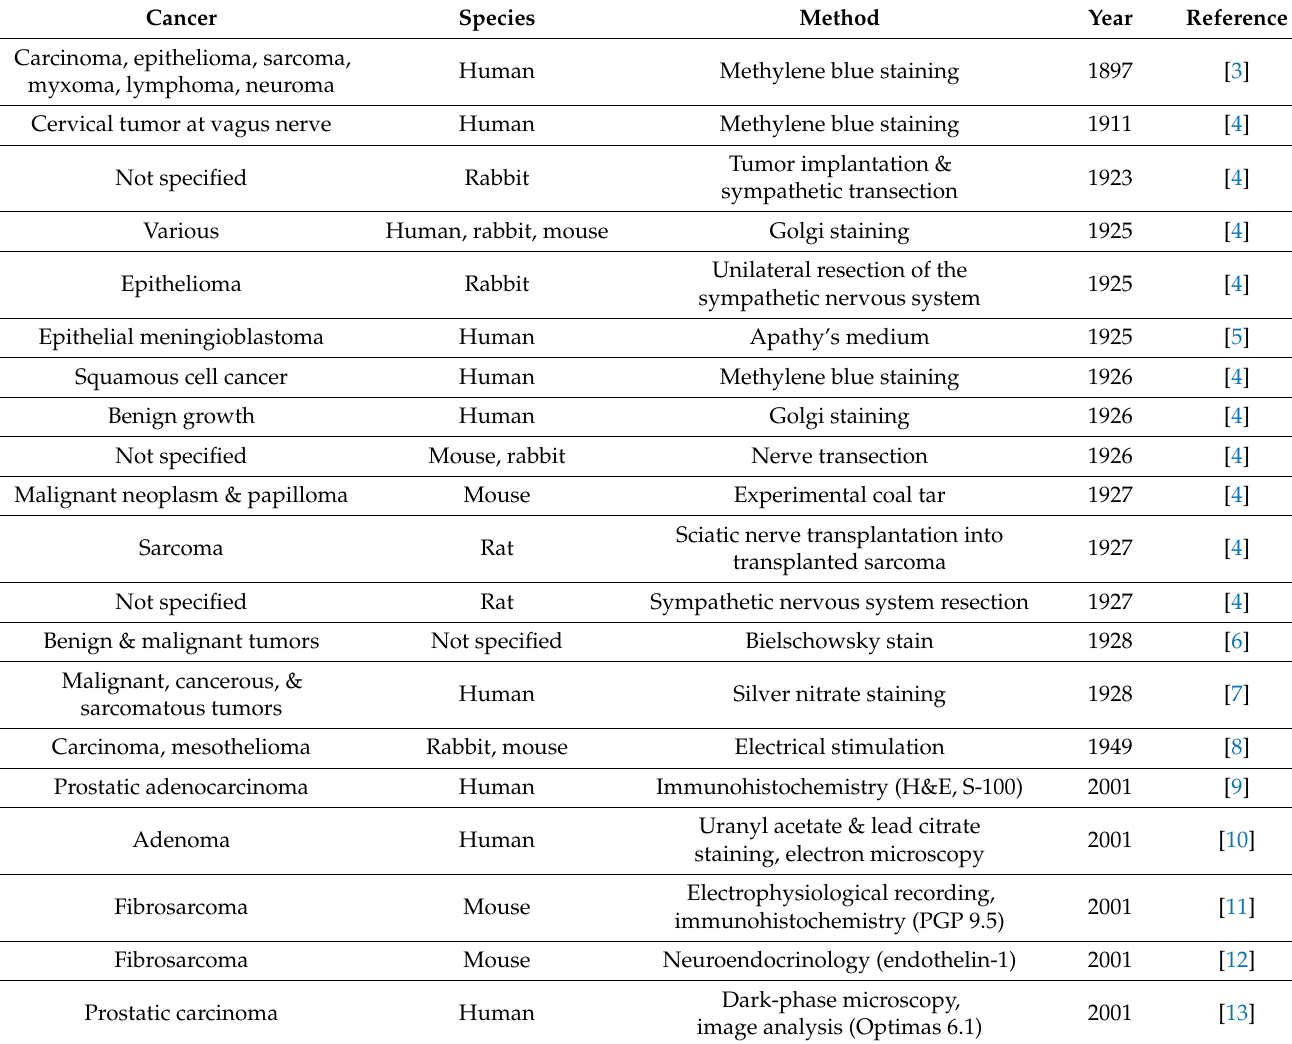
Table 1. Observations of tumor